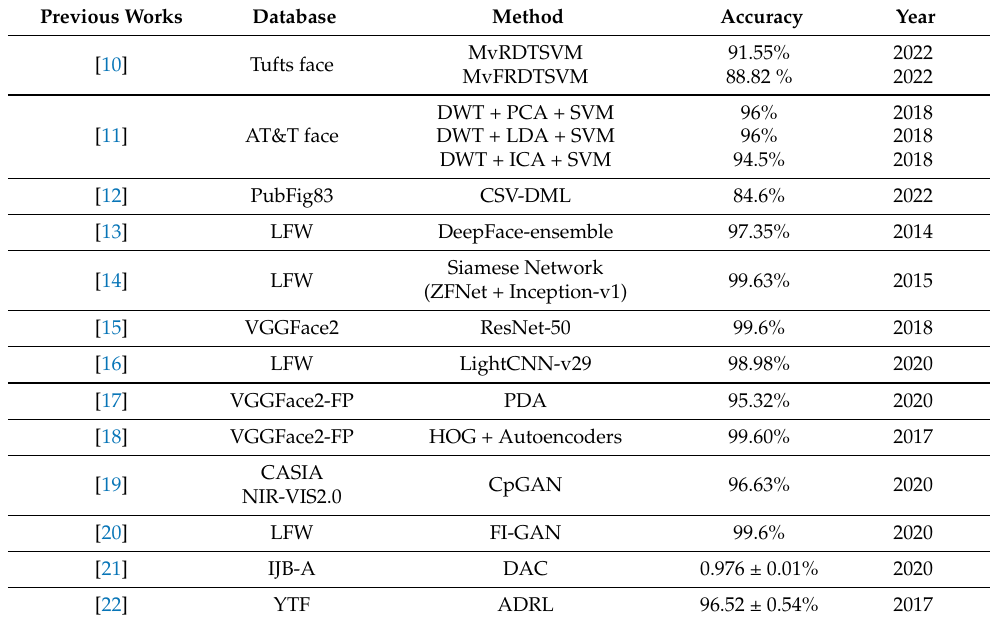
Table 1. Previous works of face